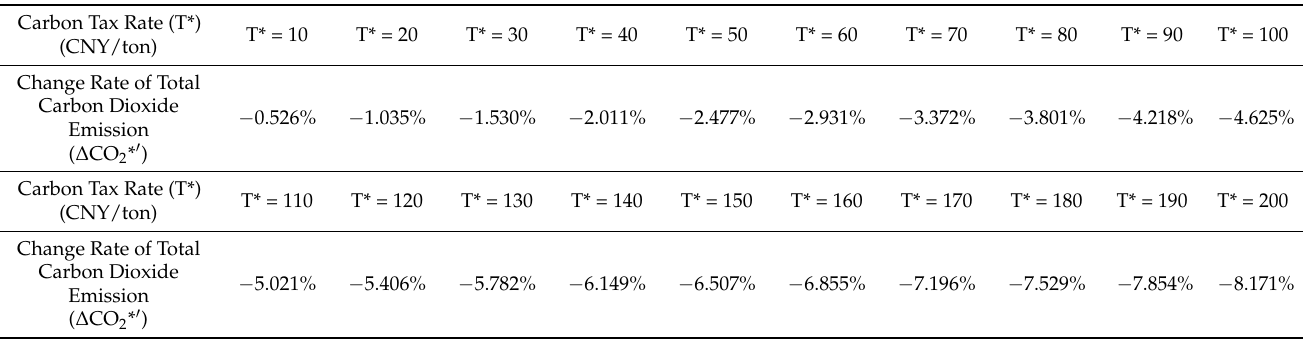
Table 5. Relationship between carbon tax and total carbon emissions. The impact of different carbon tax rates on the change of carbon dioxide emission.